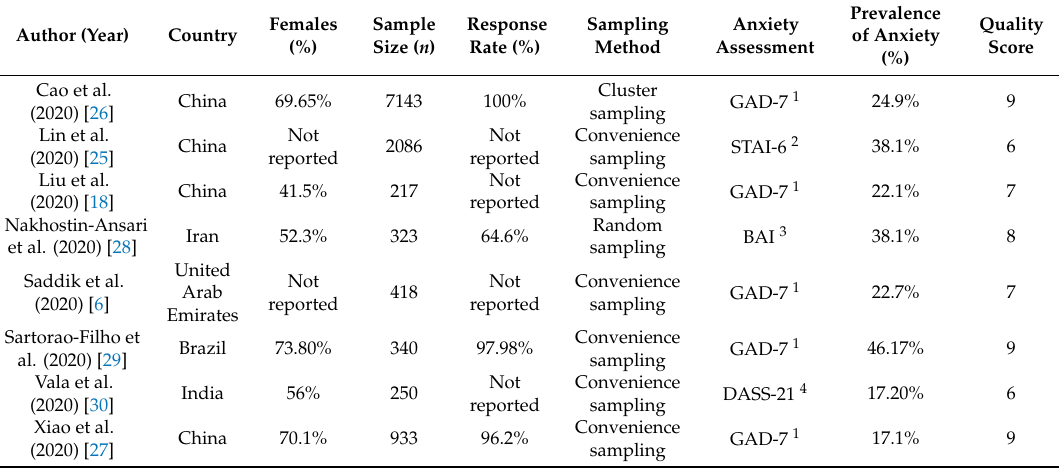
Table 1. Characteristics of included studies in the